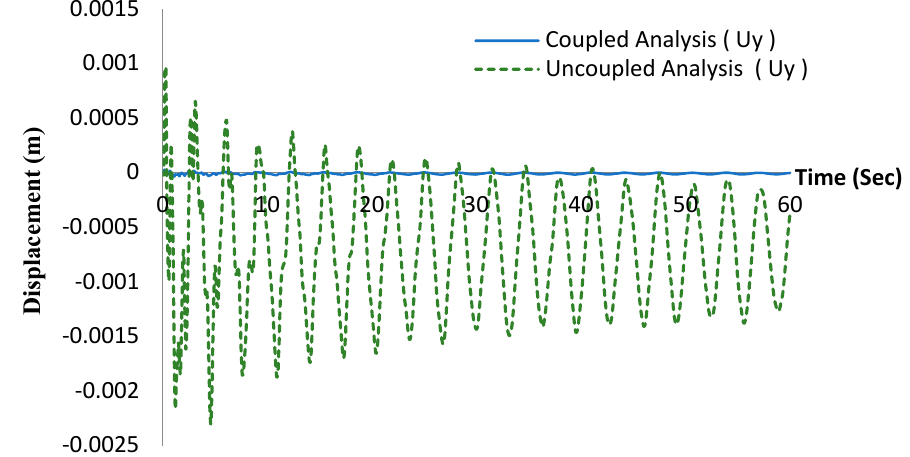
Figure 15. Comparison of displacements in the y-direction resulting from coupled and uncoupled analyses.